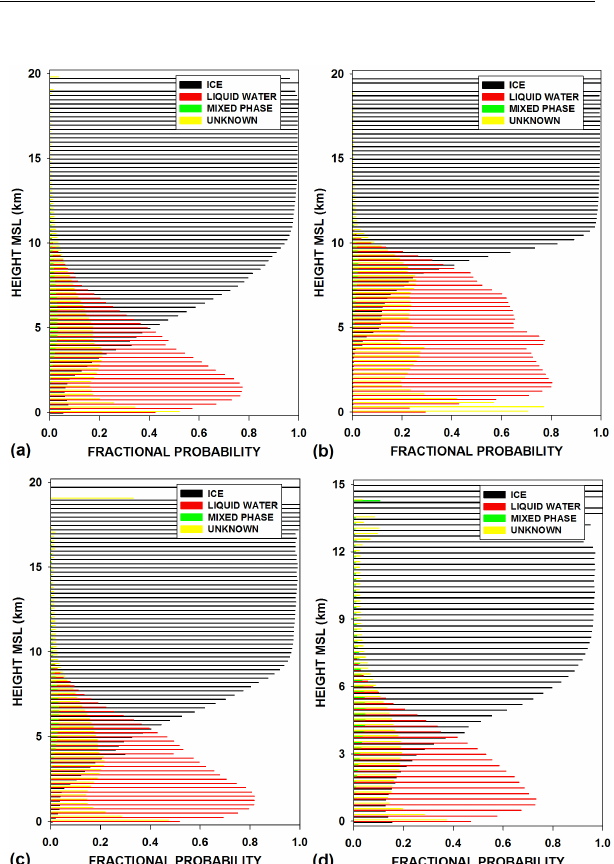
Figure 5. Fractional phase probabilities (ice, liquid water, mixed phase and unknown; see insets) in 250m height intervals for 2012 CALIOP V3.02 L2_CPro-5km clouds from 0 to 20kma.m.s.l for (a) all global cases (ice, liquid water, mixed phase and unknown), (b) the tropics ( θ ≤ | 30 ◦ | ), (c) midlatitudes ( | 30 ◦ | < θ ≤ | 60 ◦ | ) and (d) from 0 to 15kma.m.s.l. at the poles ( θ > | 60 ◦ |